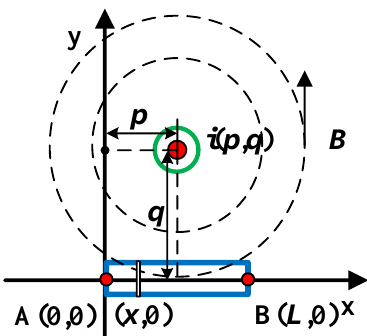
Figure 4. Relative position of the wire conductor to the sensor.